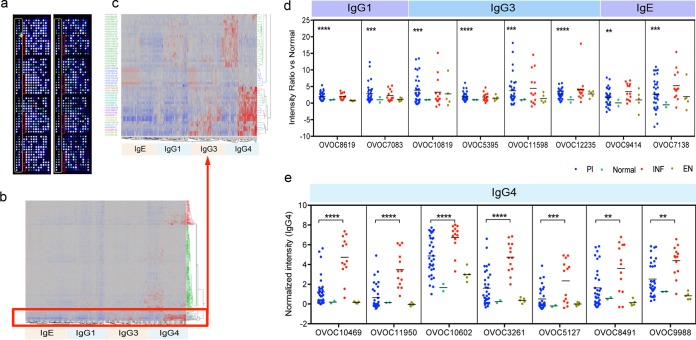
O. volvulus protein array. (a) Quality control of O. volvulus protein array chips with anti-HA (right) and anti-His (left) antibodies. (b) Heat map depicting the clustered data from all samples for all isotypes with a blowup of the red-boxed image in panel c highlighting the cluster of IgG4-reactive proteins. Red to blue denotes high to low reactivity. (d) Scatter plots of representative proteins with significant IgG1, IgG3, and IgE responses (potentially allergenic) in putatively immune individuals compared to infected individuals, plotted as ratios with respect to normal serum samples. **, P ≤ 0.01; ***, P ≤ 0.001; ****, P < 0.0001 (one-way ANOVA corrected for multiple comparisons [Holm-Sidak]). (e) Scatter plot of representative proteins with significant IgG4 reactivity in infected individuals, plotted as normalized intensity. PI, putatively immune; INF, infected individuals; EN, endemic normal individuals; Normal, pools of healthy normal donors.